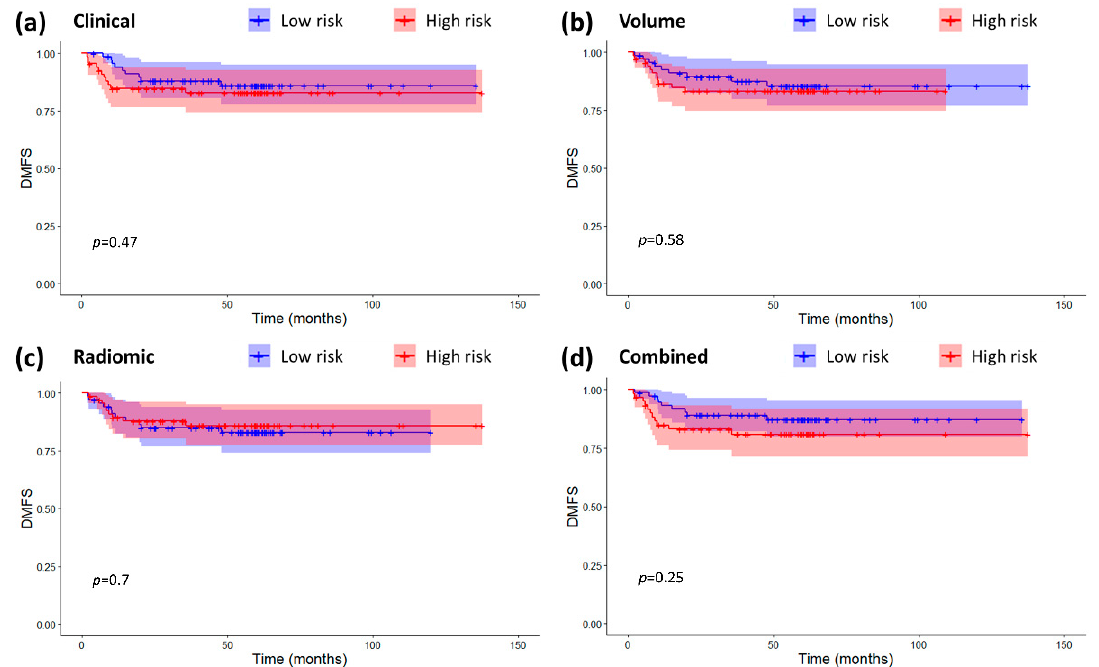
Figure 4. Kaplan-Meier curves and confidence intervals for loco-regional distant metastasis-free survival (DMFS) in the high and low risk groups as defined by the four prognostic models. ( a ) Clinical model. ( b ) Volume-based model. ( c ) Radiomic model. ( d ) Combined radiomic-clinical model. The p -values for the log-rank tests are also displayed on the plots. Crosses represent censored data.